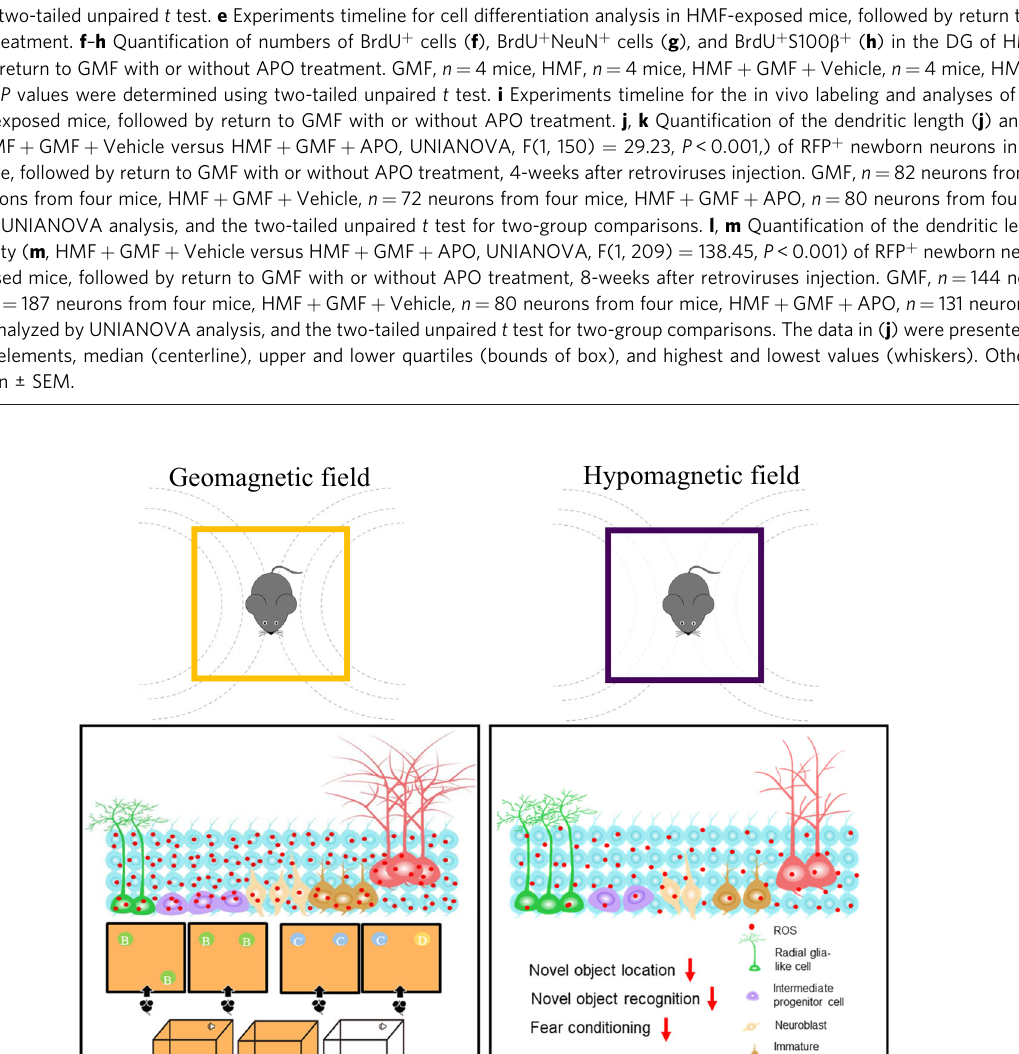
Fig. 7 APO blocked the recovery effects of GMF return on defective adult hippocampal neurogenesis of HMF-exposed mice. a Experiments timeline for cell proliferation analysis in HMF-exposed mice, followed by return to GMF with or without APO treatment. b - d Quanti fi cation of numbers of BrdU + Sox2 + GFAP + cells ( b ) and BrdU + Sox2 + GFAP – cells ( c ) and active caspase-3 + DCX + cells ( d ) in the DG of HMF-exposed mice, followed by return to GMF with